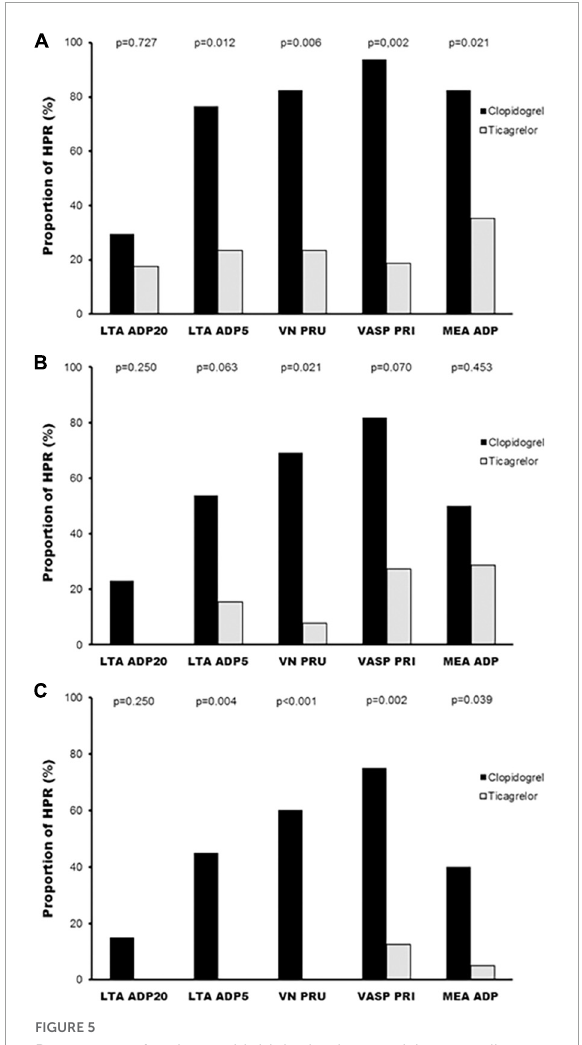
FIGURE5 Percentage of patients with high platelet reactivity according to treatment with all platelet function tests and agonists. (A) HPR rates at 2 h; (B) HPR rates at 24 h; (C) HPR rates at 1 week. HPR, high on-treatment platelet reactivity; LTA, light transmission aggregometry; MEA, multiple electrode aggregometry; PRI, platelet reactivity index; PRU, P2Y 12 reaction units; VN, VerifyNow; VASP, vasodilator-stimulated